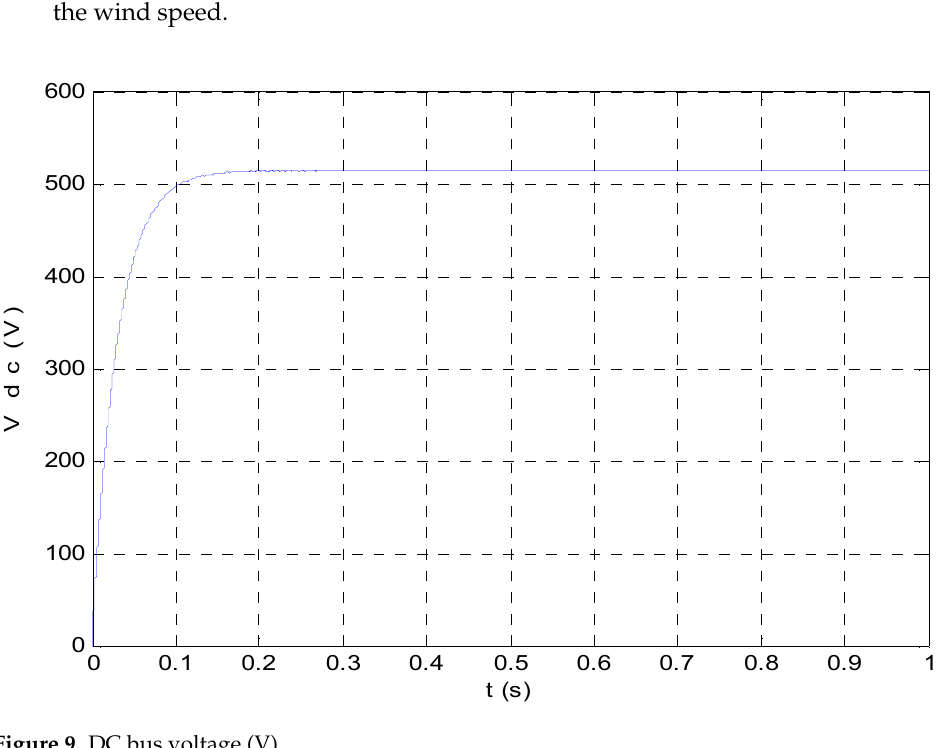
Figure 9. DC bus voltage (V).